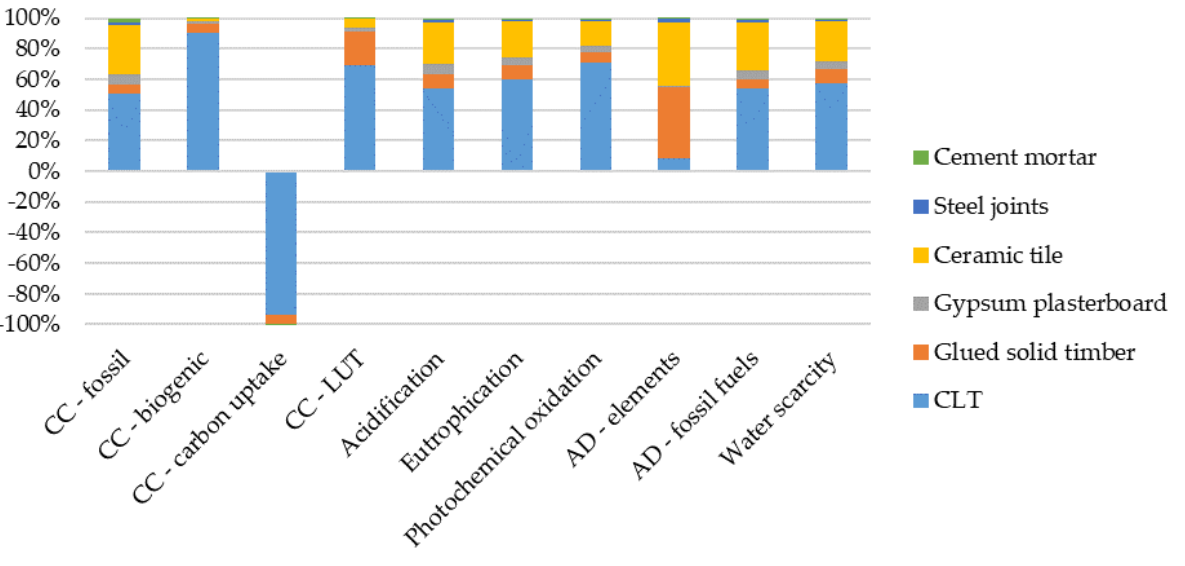
Figure 13. Impact assessment of foundations construction materials.